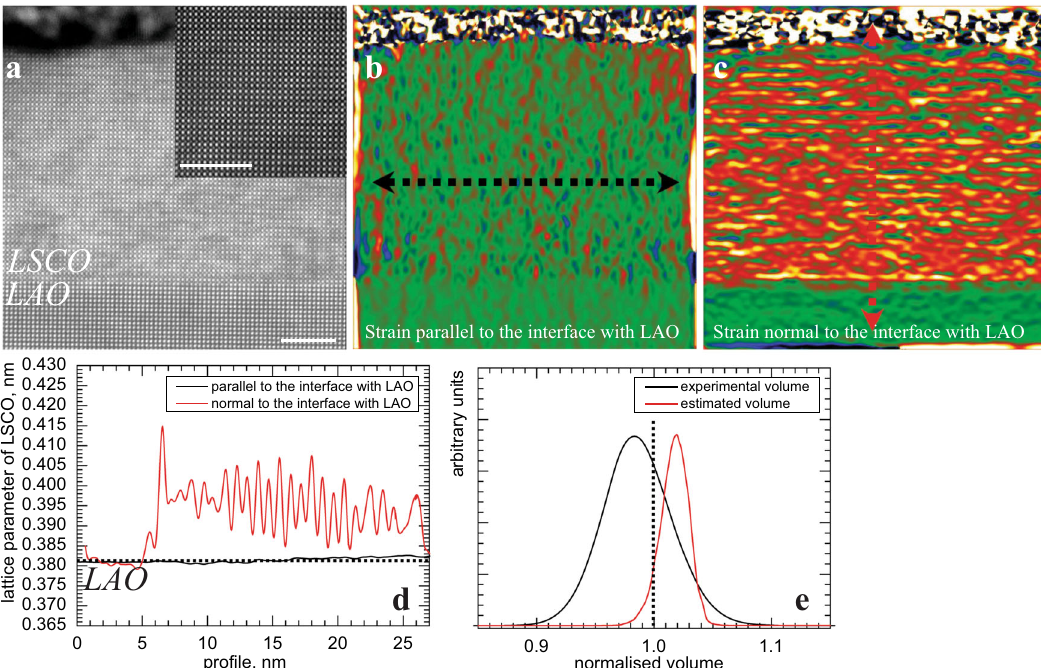
Fig. 7 Geometrical Phase Analysis of LSCO thin fi lm grown on LAO(100) substrate. a HAADF STEM image, b , c strain mapping parallel and normal to the interface with the substrate, d pro fi les of the in-plane and out-of-plane lattice parameter corresponding to the dashed lines in b and c , e cell volume of the LSCO normalized to its bulk value measured and estimated by assuming a simple elastic model. The insert in a shows the magni fi ed HAADF image. The scale bar is 5 nm.